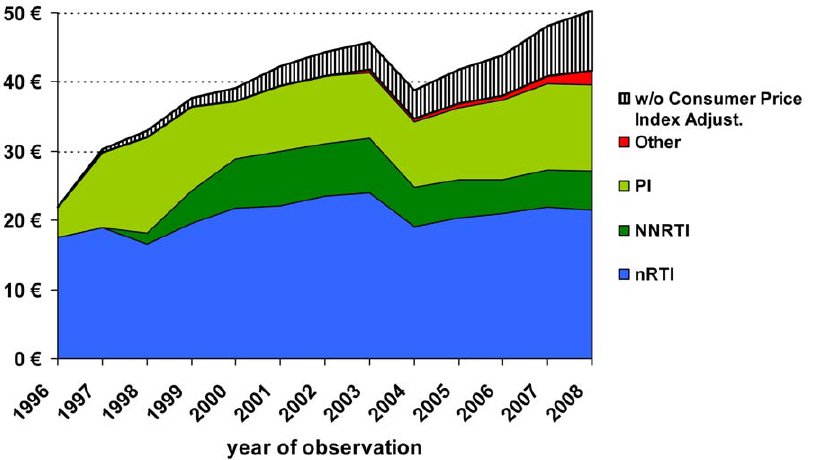
Figure 4. Mean daily treatment costs of antiretrovirals by class and year after adjustment for the German consumer price index (1996=100), annual increments of consumer price index in %: 1996: 1.4%, 1997: 1.9%; 1998: 1.0%; 1999: 0.6%; 2000: 1,4%; 2001: 1.9%; 2002: 1.5%; 2003: 1.0%; 2004: 1.7%; 2005: 1.5%; 2006: 1.6%; 2007: 2.3%; 2008: 2.6%. doi:10.1371/journal.pone.0023946.g004 PLoS ONE |